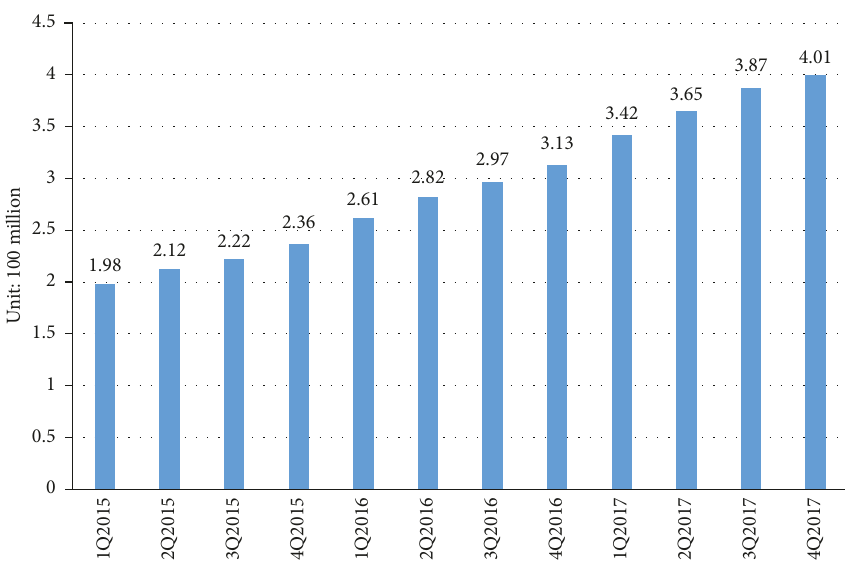
Figure 4: Number of active users of Weibo in the past three